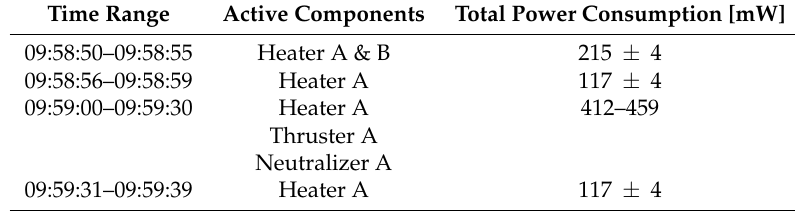
Figure 9. First in-orbit activation of thruster A on 26 February 2019. ( a ) Emitter voltage U mon of thruster A. ( b ) The monitored currents of thruster A. ( c ) The power consumption of the PPU, the neutralizer, and the thruster with its associated heater within their uncertainties. Table 1. The power consumption of the different operational modes in Figure